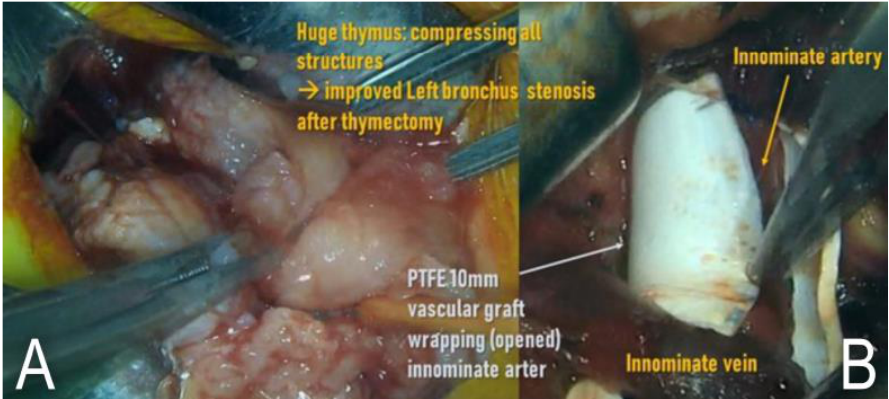
Figure 4. Surgical filed photo images. ( A ) Huge thymus was removed, and ( B ) polytetrafluoroeth- ylene vascular graft wrapped the innominate artery.